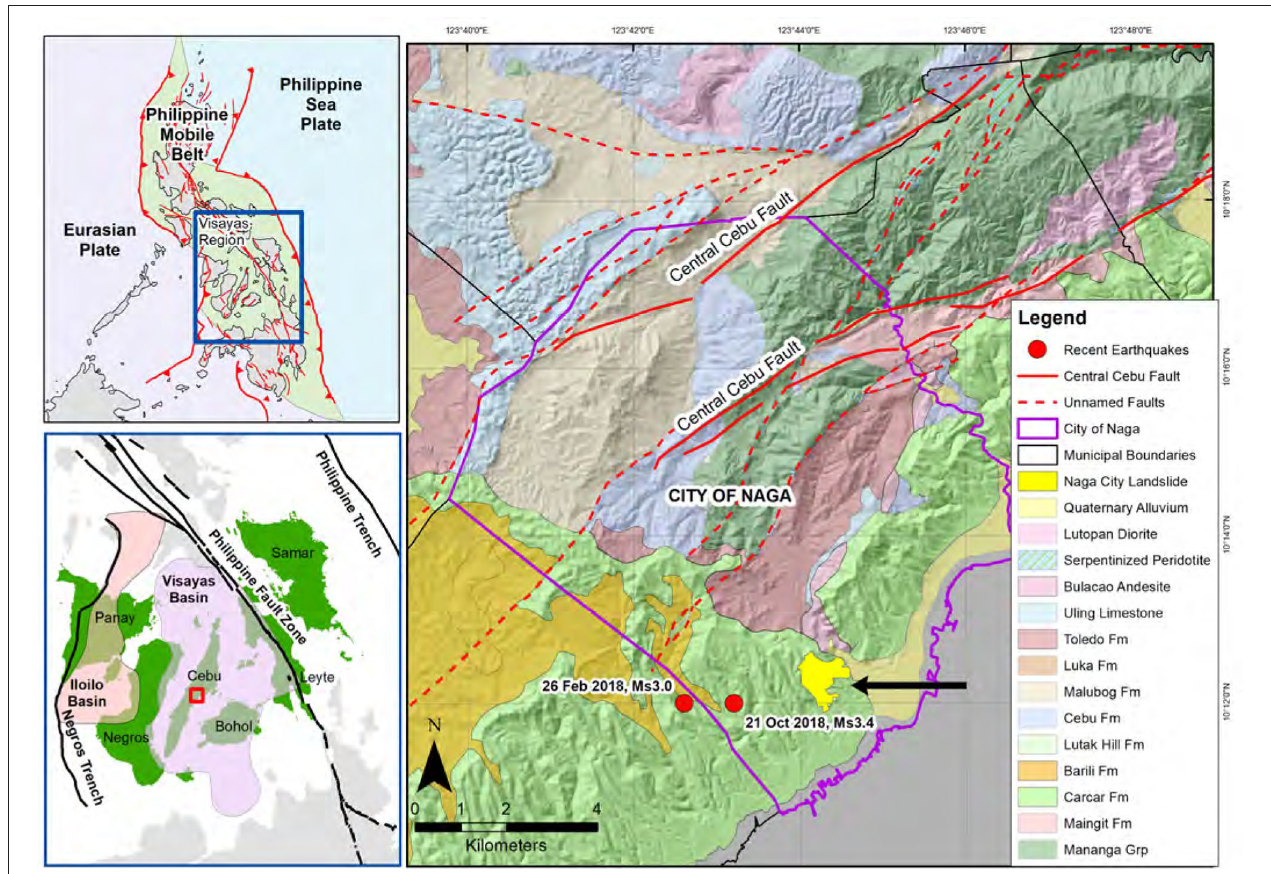
FIGURE 2 | The PMB is found within the convergent zone between the Philippine Sea Plate and the Eurasian Plate (adapted from Lagmay et al., 2009). The Visayas Region contains the Iloilo Basin and the Visayas Basin, wherein Cebu is located (adapted from Dimalanta et al., 2006). The City of Naga is located in central Cebu which is underlain by a basement complex of igneous, volcanic, sedimentary, and metamorphic rocks. Nearby is the active NE-SW trending Central Cebu Fault (PHIVOLCS) as well as numerous unnamed faults ( MGB,